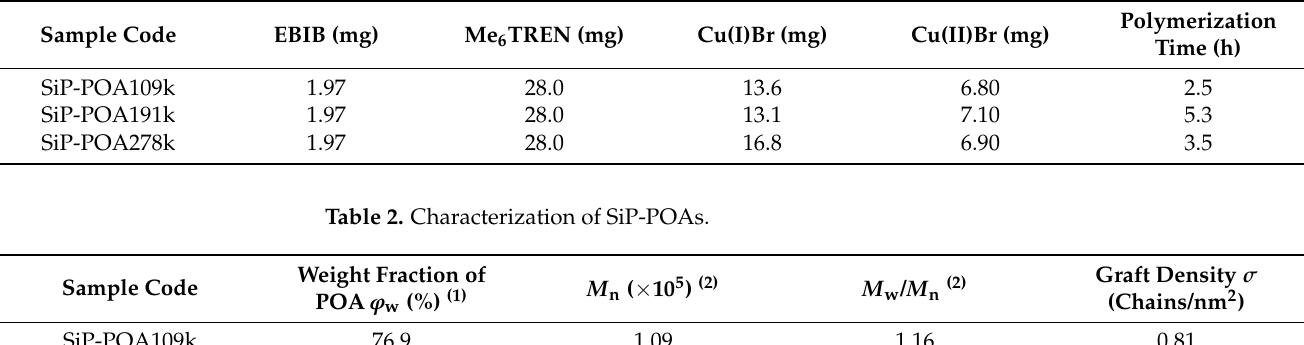
Table 1. Reaction conditions of the SI-ATRP for the synthesis of SiP-POAs.